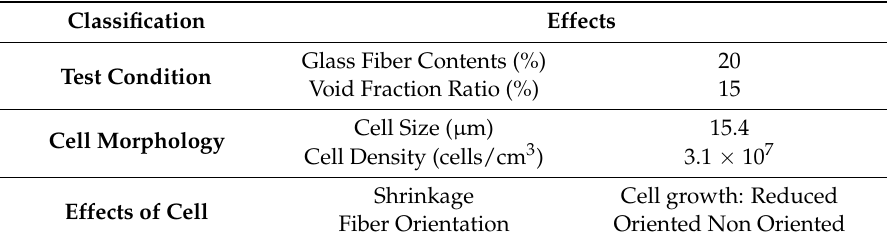
Figure 5. Scanning electron microscopy images for cell morphology analysis (magnification: 200×): ( A ) front view of solid specimen, ( B ) front view of MCP-applied specimen, ( C ) side view of solid specimen, and ( D ) side view of MCP-applied specimen. Table 2. Summary of effects of cell morphology on shrinkage and fiber orientation.